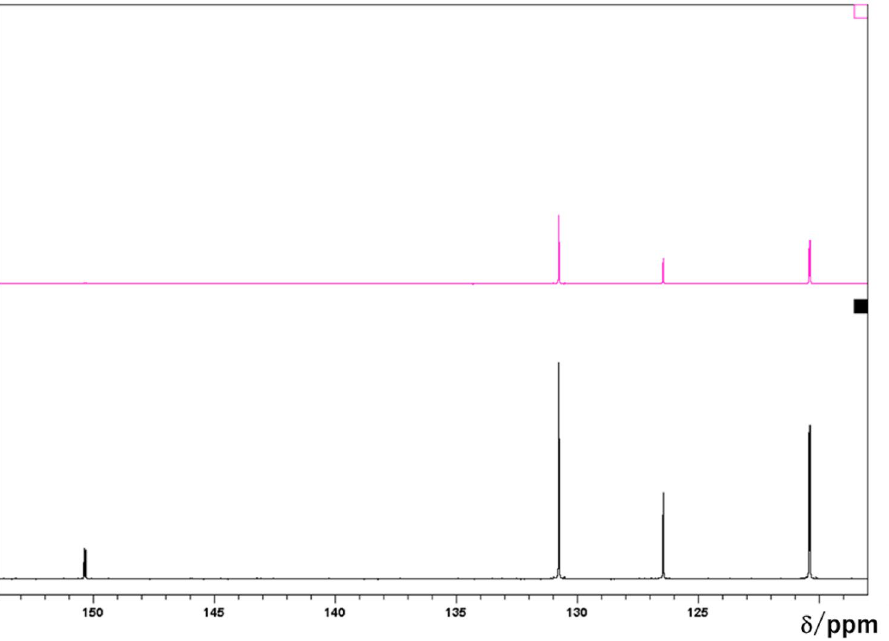
Figure 1. 13 C NMR spectra of the white precipitate: standard 13 C spectrum (lower panel) and DEPT spectrum (upper